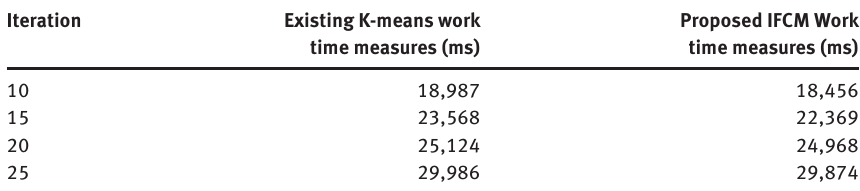
Table 5: Comparison for Proposed and Existing Time Measures. Iteration